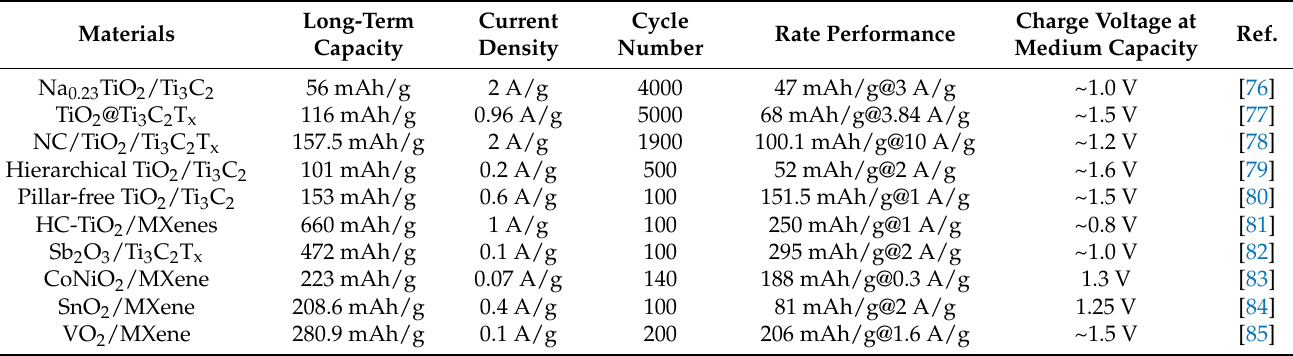
Table 3. Performance comparison of oxide/MXene composites in